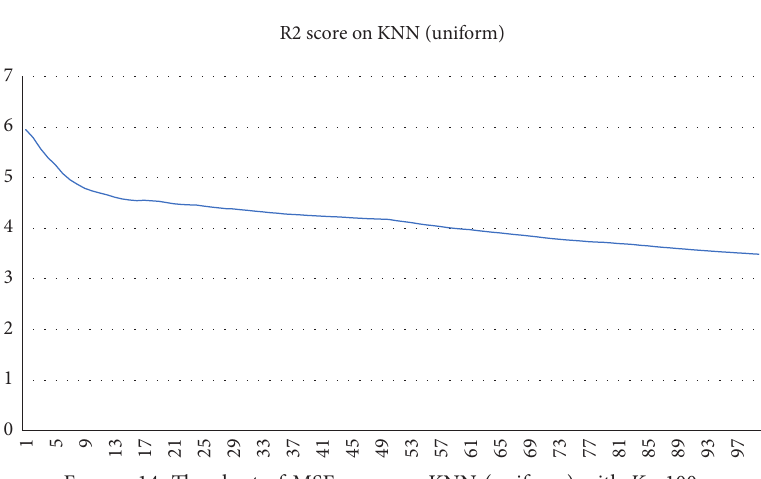
Figure 13: The chart of R 2 score on KNN (uniform) with K � 100.